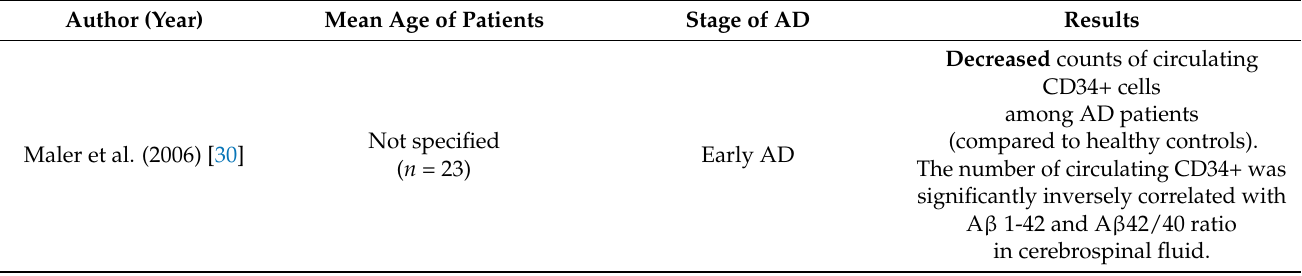
Table 1. A summary of studies on number of circulating EPCs in patients with Alzheimer’s